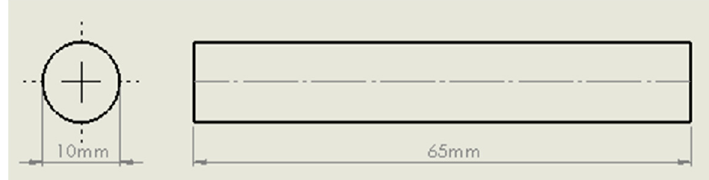
Figure 1. Specimen dimensions .